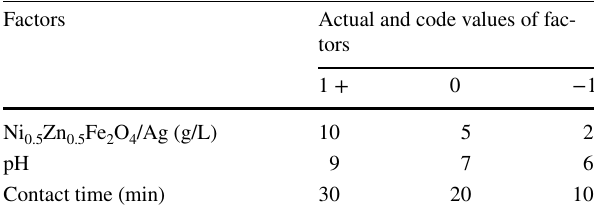
Table 1 Selected factors and levels for the removal of E. coli Factors Actual and code values of fac-